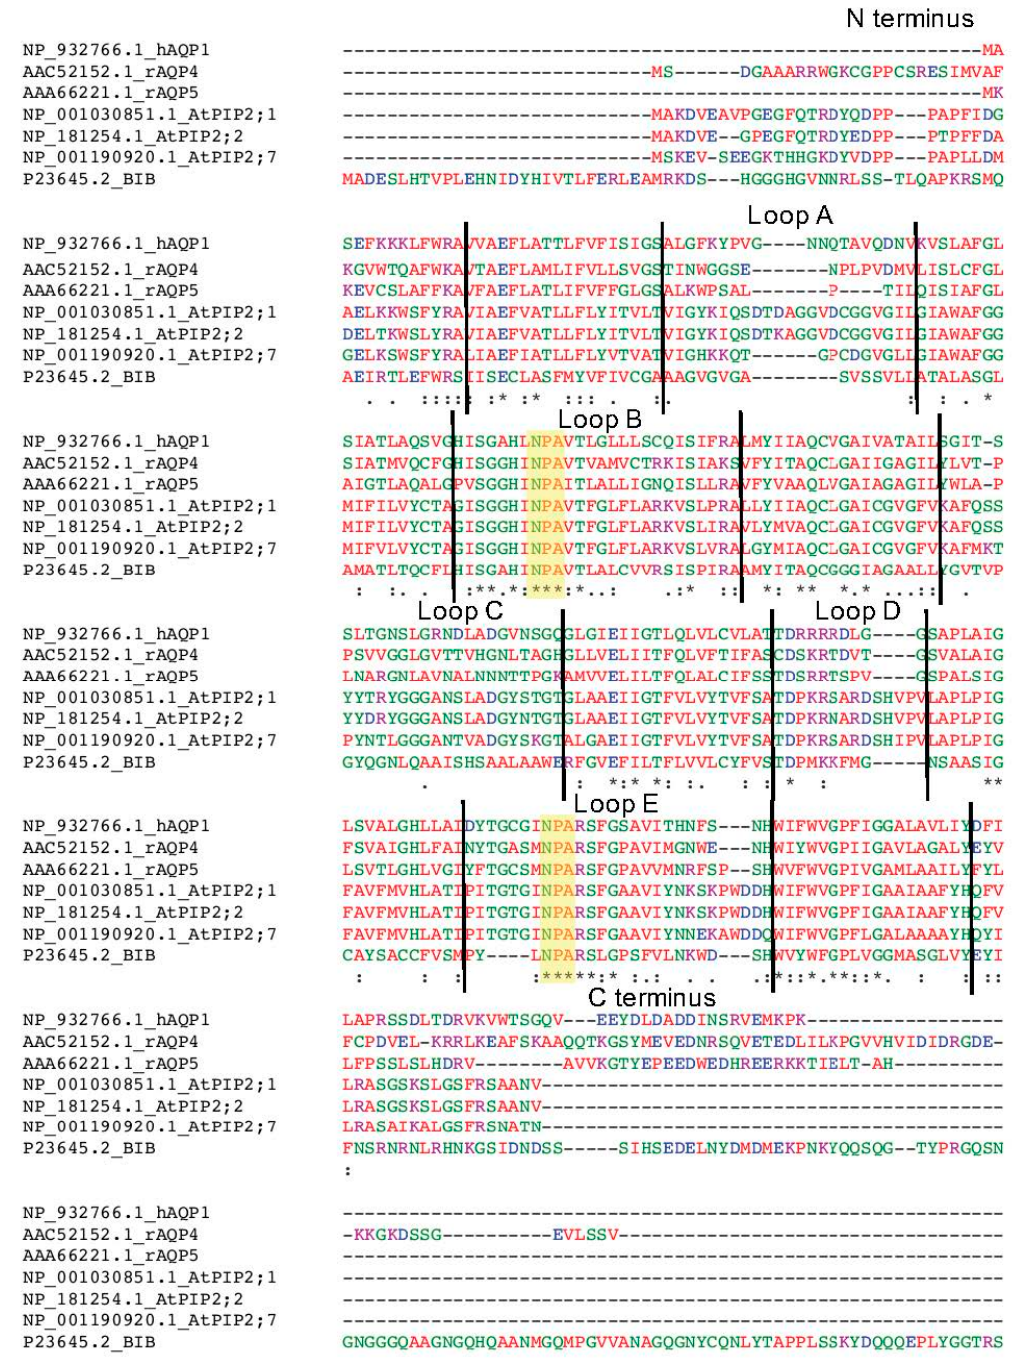
Figure 7. Amino acid sequence alignment of HsAQP1, RnAQP4, RnAQP5, AtPIP2;1, AtPIP2;2, AtPIP2;7 and DmBIB. Sequences from the NCBI Protein Database were aligned using Clustal Omega software (Available online: http://www.ebi.ac.uk/Tools/msa/clustalo/; accessed on 18 October 2017). HsAQP1 protein topology was from the Topology Data Bank of Transmembrane Proteins (TOPDB). Symbols: asterisk (*) identical residues across all sequences; colon (:) highly conserved residue; period (.) semi-conserved residue. Hyphens (-) show gaps; black vertical lines separate predicted domains, as labelled. Colors illustrate chemical properties: positive charged (magenta), negative charged (blue), polar (green), hydrophobic (red). Highlighted in yellow are NPA (Asn-Pro-Ala) signature motifs located in loops B and E, conserved in most aquaporins. The carboxy terminus of DmBIB was truncated for this figure.